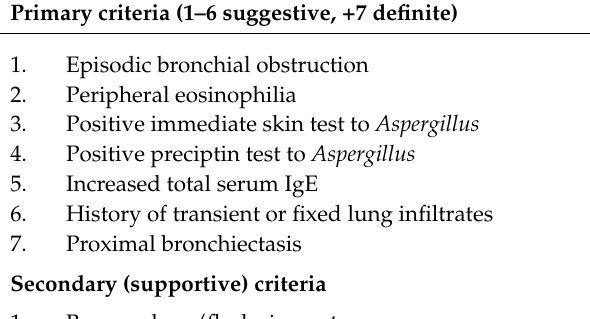
Table 1. Rosenberg-Patterson 1977 criteria for diagnosis of ABPA